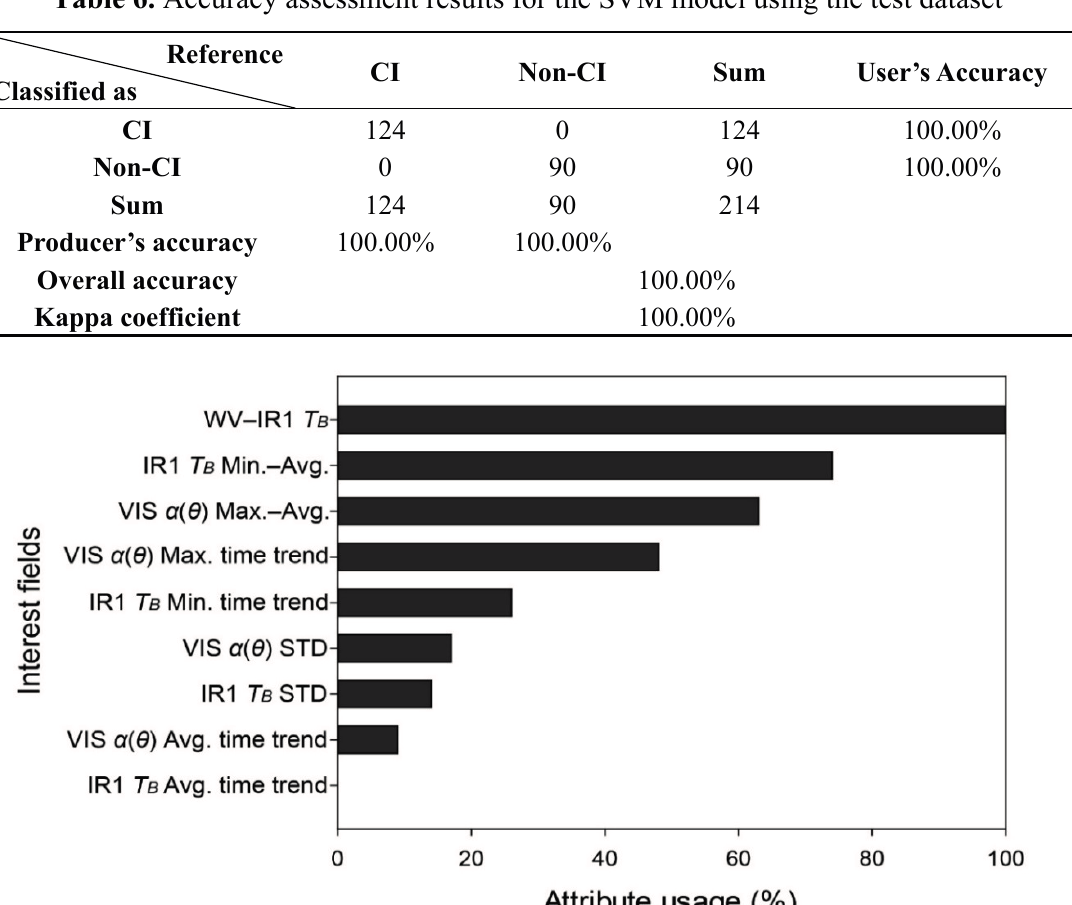
Figure 3. Attribute usage of the DT